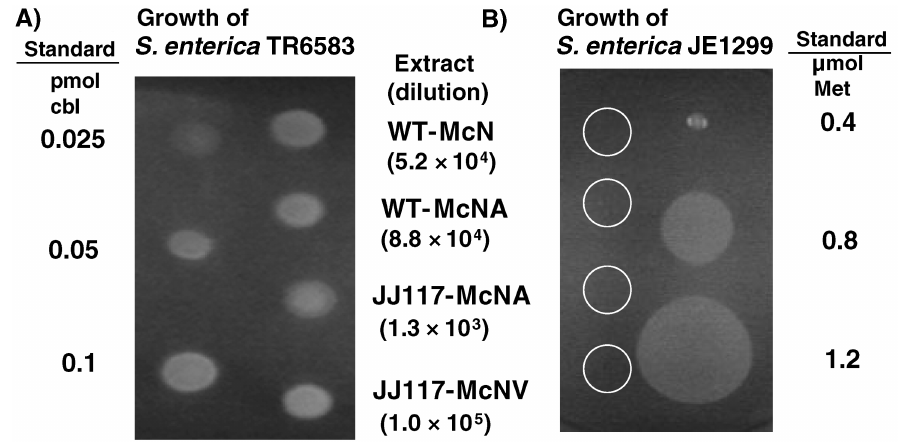
Figure 6. Bioassay for cob- amides in cell extracts of the wild type and JJ117. All